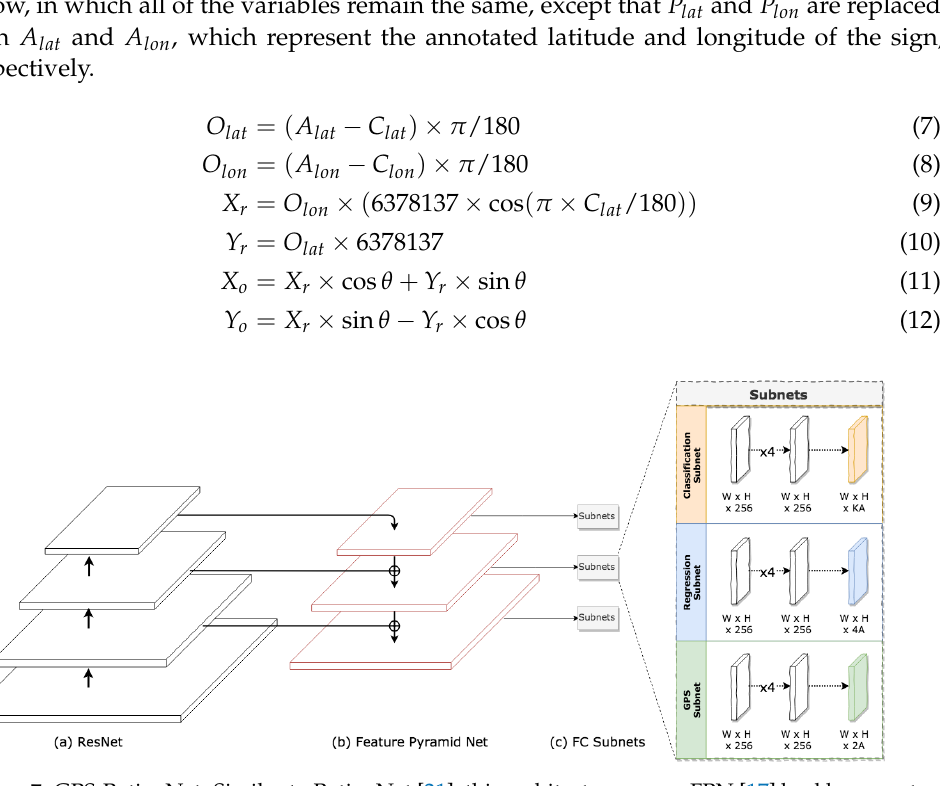
Figure 7. GPS-RetinaNet. Similar to RetinaNet [21], this architecture uses a FPN [17] backbone on top of a ResNet [33] model ( a ) to create a convolutional feature pyramid ( b ). Then, we attach three sub- networks ( c ); one for classification, one for box regression, and one for GPS/depth